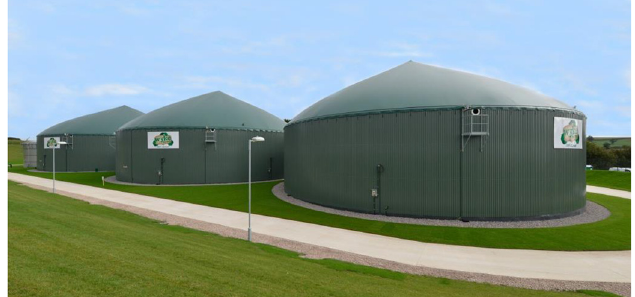
Fig. 11. Anaerobic digesters in the UK.